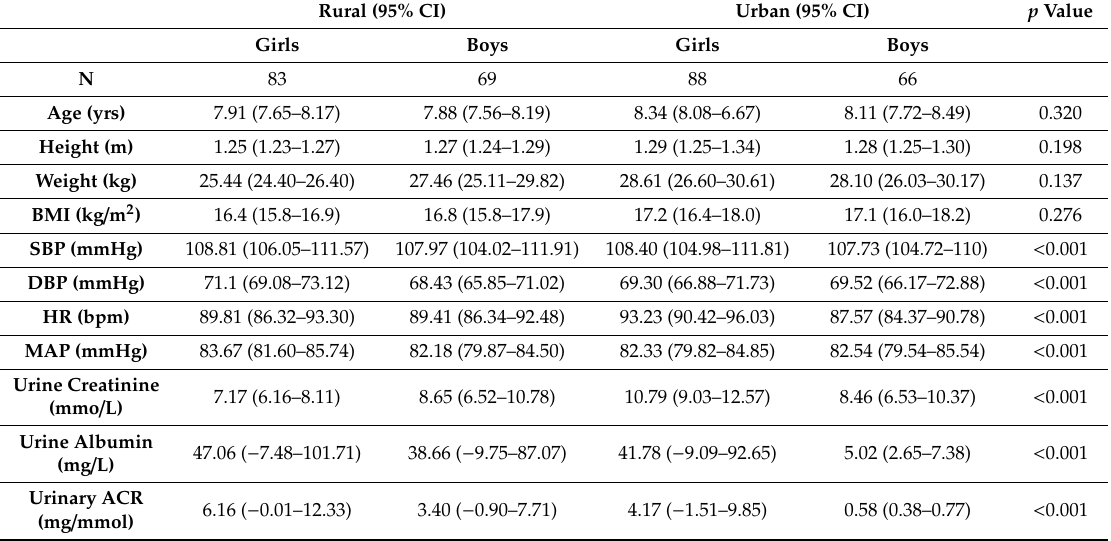
Table 1. Baseline characteristics of participating